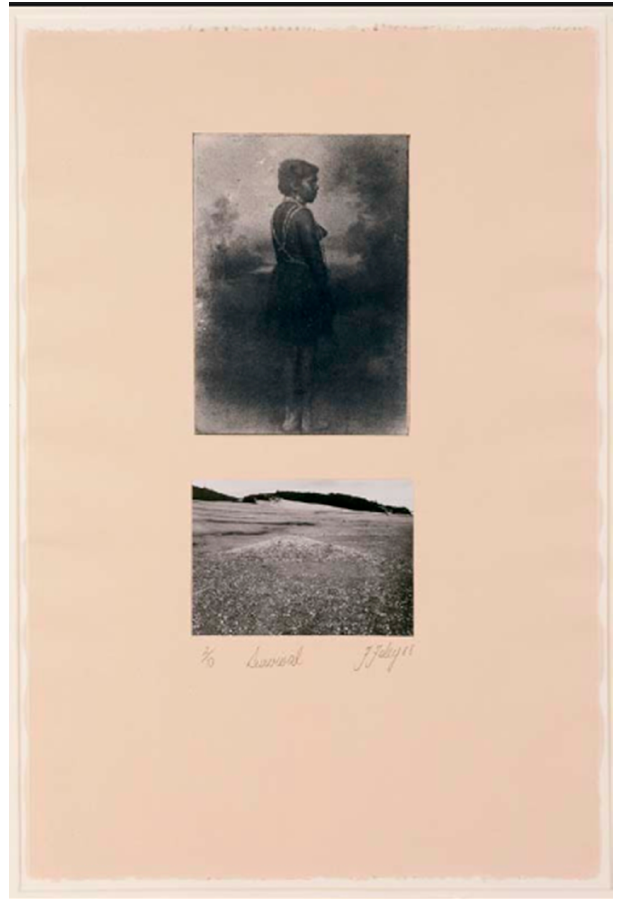
Figure 1. Fiona Foley’s Survival I, II (1988). Photo etching and collage on brown paper. Edition 2 / 10. Two of four sheets: 56.5 × 38 cm (each). Courtesy of Queensland Art Gallery and Gallery of Modern Art, Brisbane, Australia.